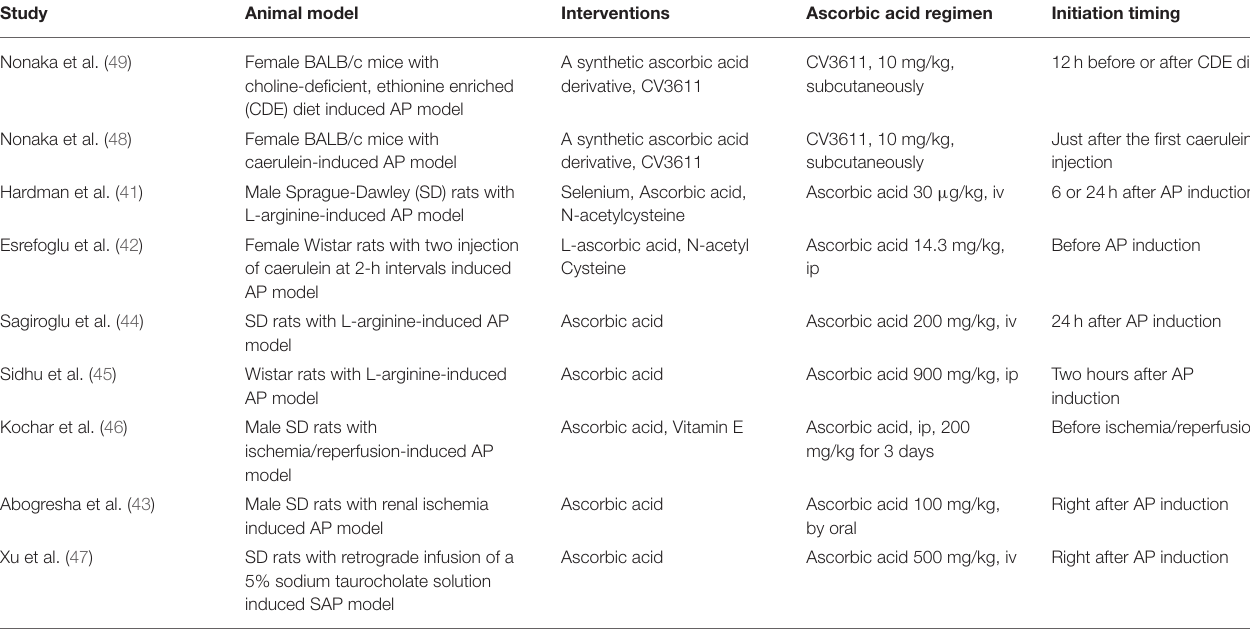
TABLE 2 | Characteristics of preclinical studies included in the